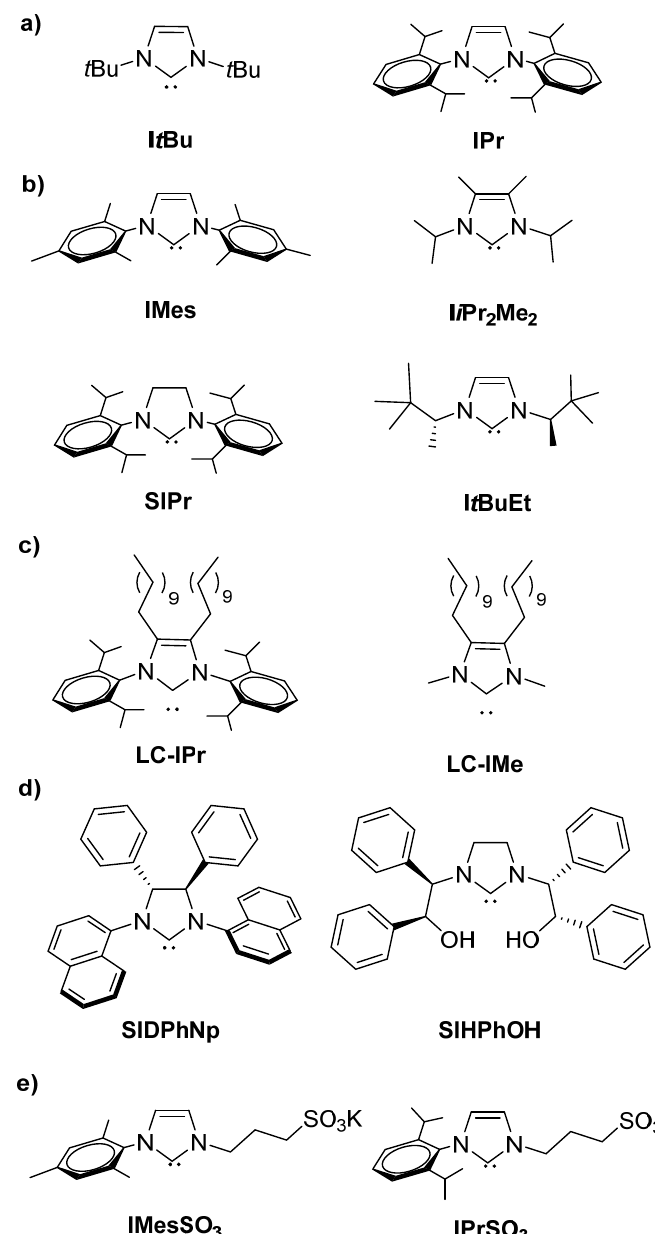
Figure 4. ( a – b ) Isolable NHCs used by Lara et al . in references 12 and 69. Non ‐ isolable ( c ) long ‐ chain, Figure 4. ( a , b ) Isolable NHCs used by Lara et al. in references 12 and 69. Non-isolable ( c ) long-chain, ( d ) chiral and ( e ) hydrosoluble NHCs used by Martínez ‐ Prieto et al . in references 13, 23, 20 and 48. ( d ) chiral and ( e ) hydrosoluble NHCs used by Mart í nez-Prieto et al. in references 13, 23, 20 and